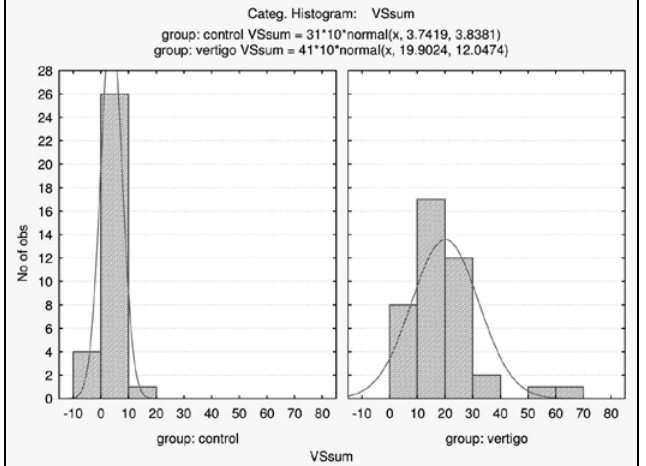
Fig. 2. Histograms depicting the spread of scores obtained on the VER subscale. The control results are in the left diagram. Scores on the VER are found on the x-axis with the number of participants found on the y-axis. Note that the control sample’s scores are substantially lower than those obtained by the vertiginous sample.